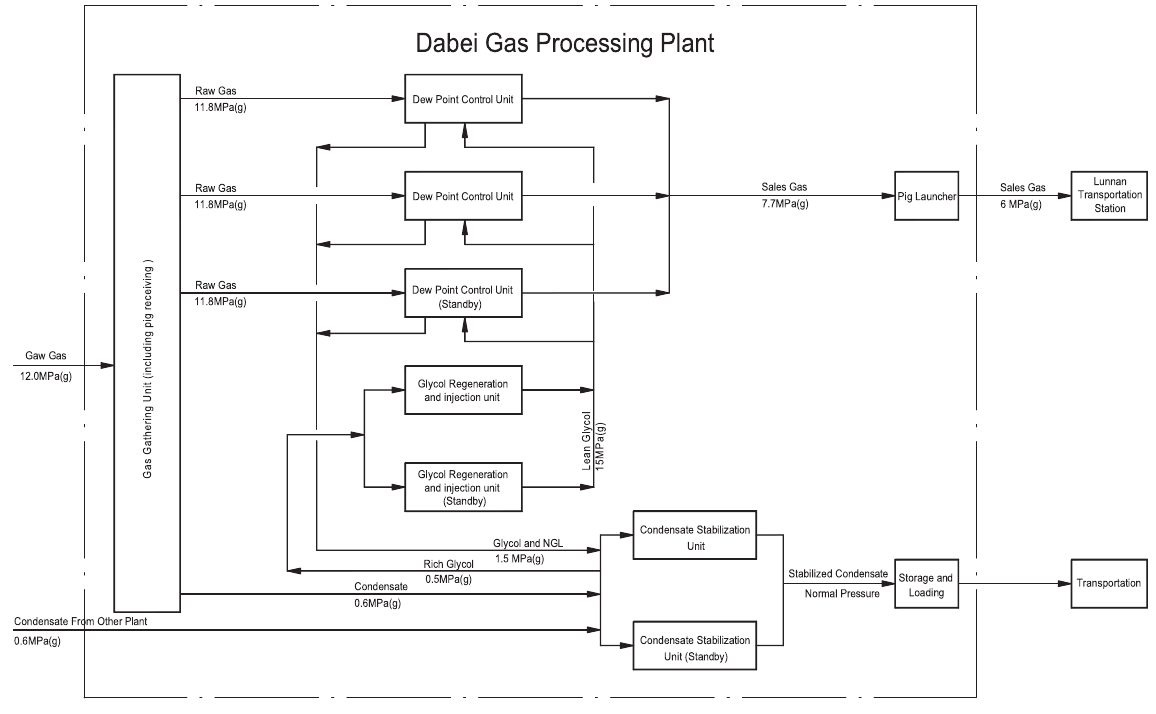
Fig. 2. The overall process fl ow